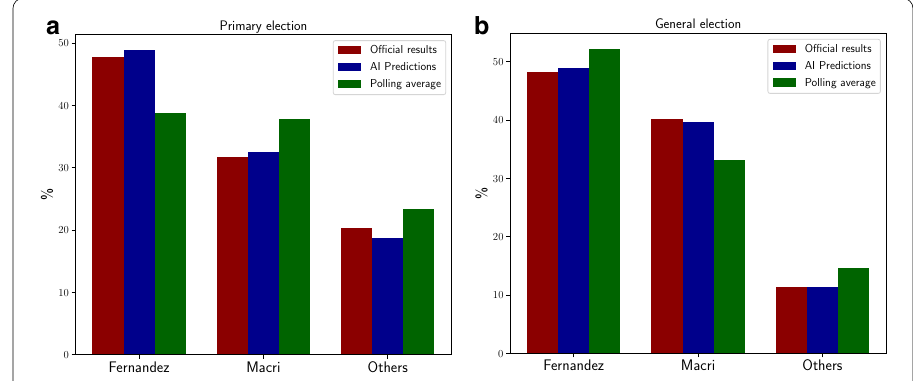
Fig. 1 Comparison between polling average (green), official results (red) and our prediction (blue) for both the ( a ) Primary (2019-08-11) and the ( b ) General election (2019-10-27) in Argentina